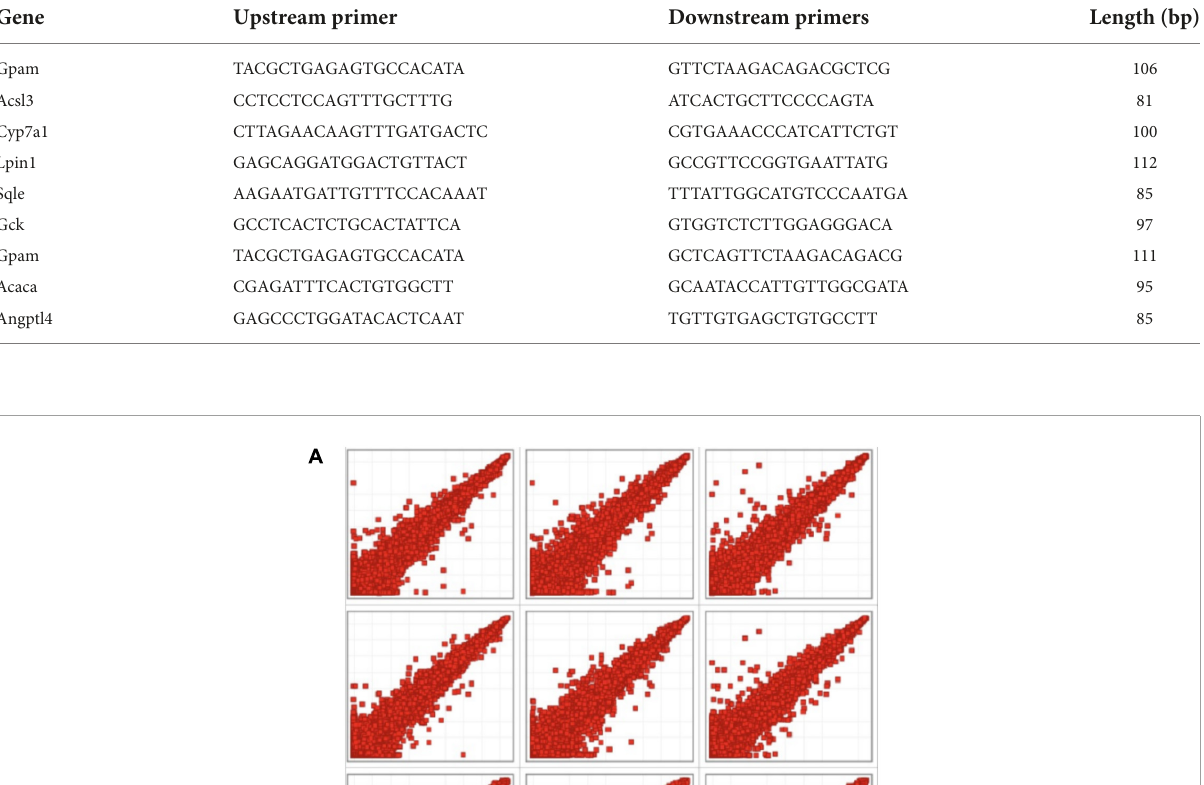
TABLE 1 Primer sequences of qPCR verified genes.